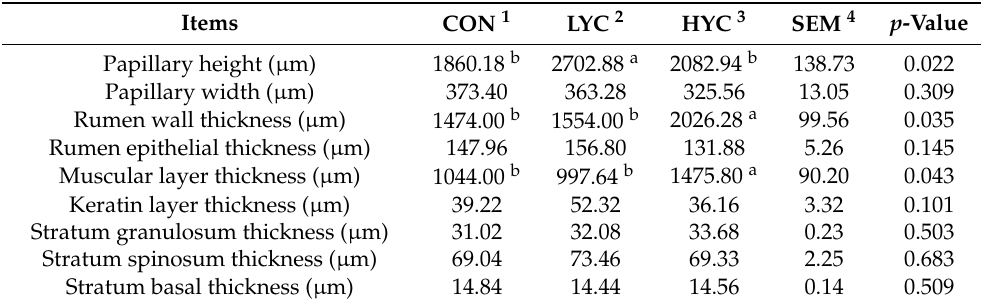
Table 6. Effect of dietary different supplemental levels of YC on morphology index of the rumen in fattening Hu